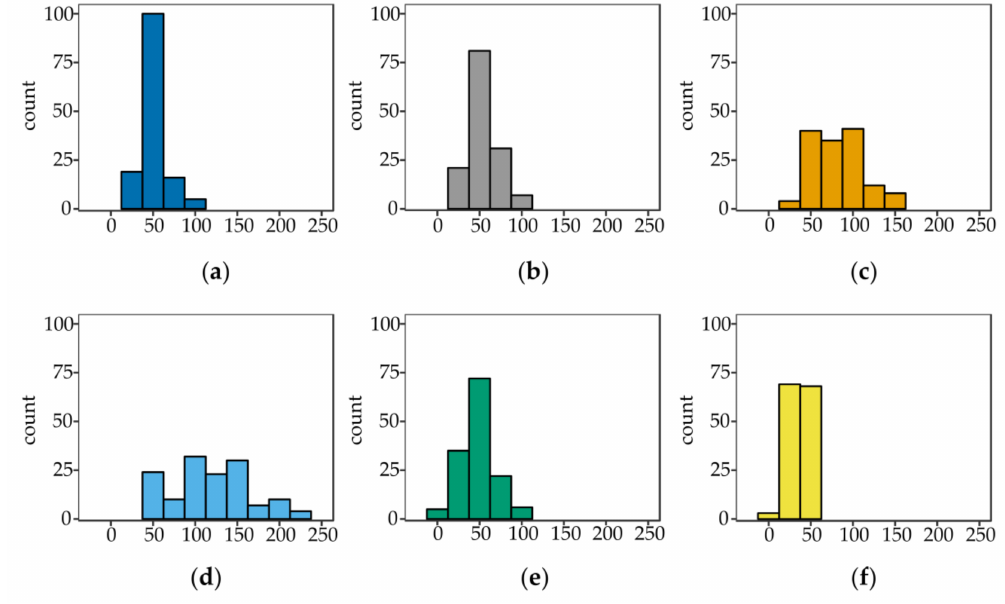
Figure 2. Fibers width (nm) distribution in ( a ) BNC, ( b ) BNC/ κ -Car 0.2 , ( c ) BNC/ κ -Car 0.5 , ( d ) BNC/ κ -Car 0.8 , ( e ) BNC/ κ -Car 2.0 and ( f ) BNC/ κ -Car 4.0